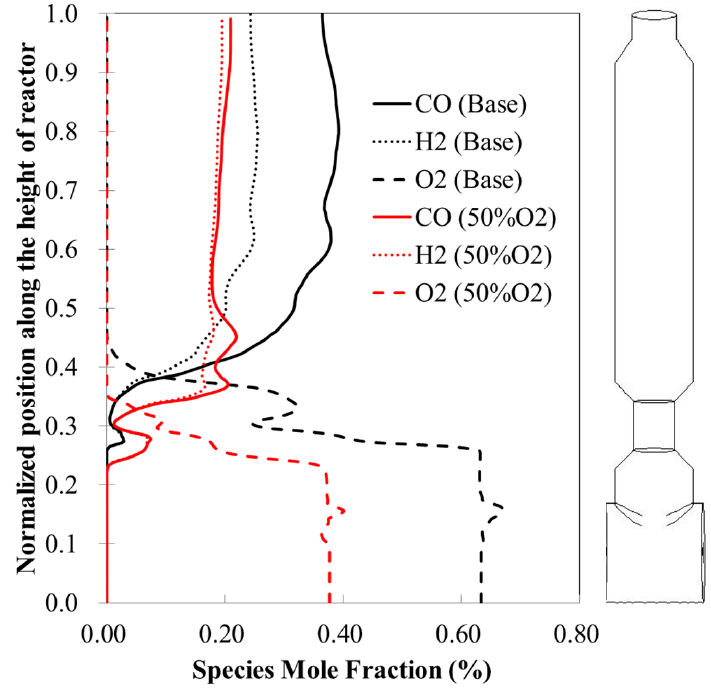
Figure 7. Comparison of CO, H 2 and O 2 distributions with half oxygen-fed condition at 28 atm.